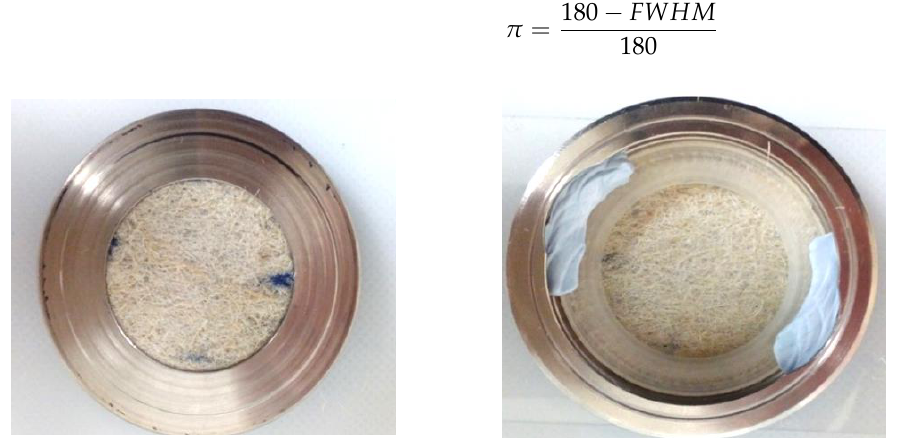
Figure 3. Photographs of a sample prepared for XRD analysis. Note the following: top view ( left ) and bottom view ( right ).